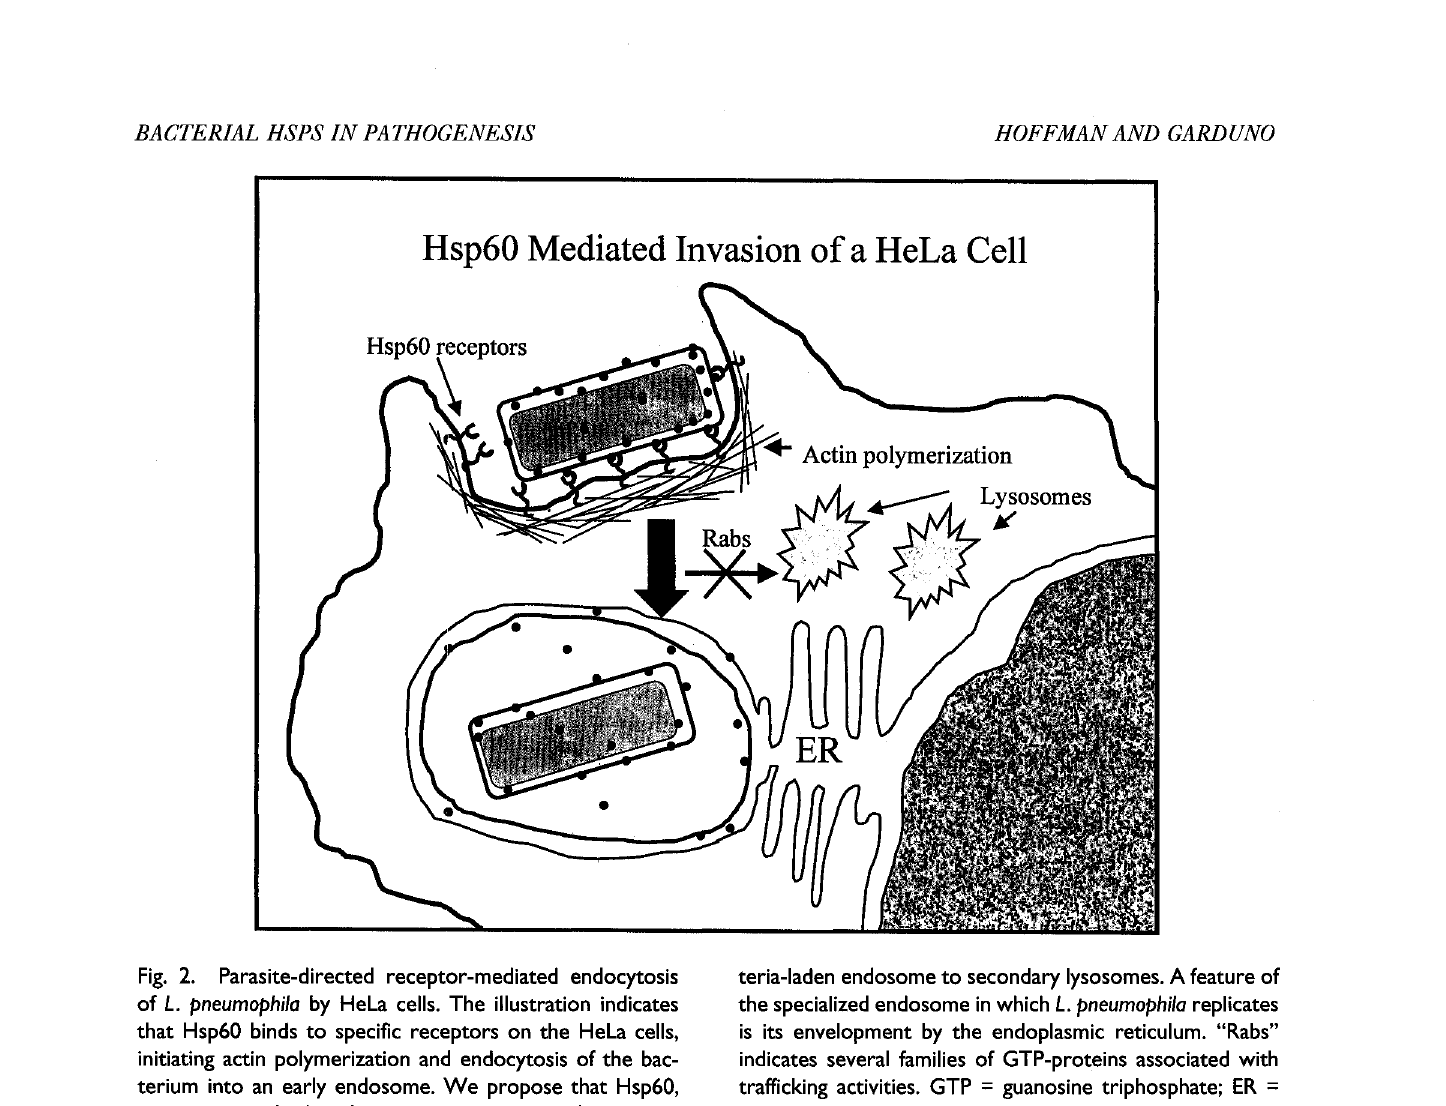
teria-laden endosome to secondary lysosomes. A feature of the specialized endosome in which L. pneumophila replicates is its envelopment by the endoplasmic reticulum. "Rabs" indicates several families of GTP-proteins associated with trafficking activities. GTP guanosine triphosphate; ER endoplasmic